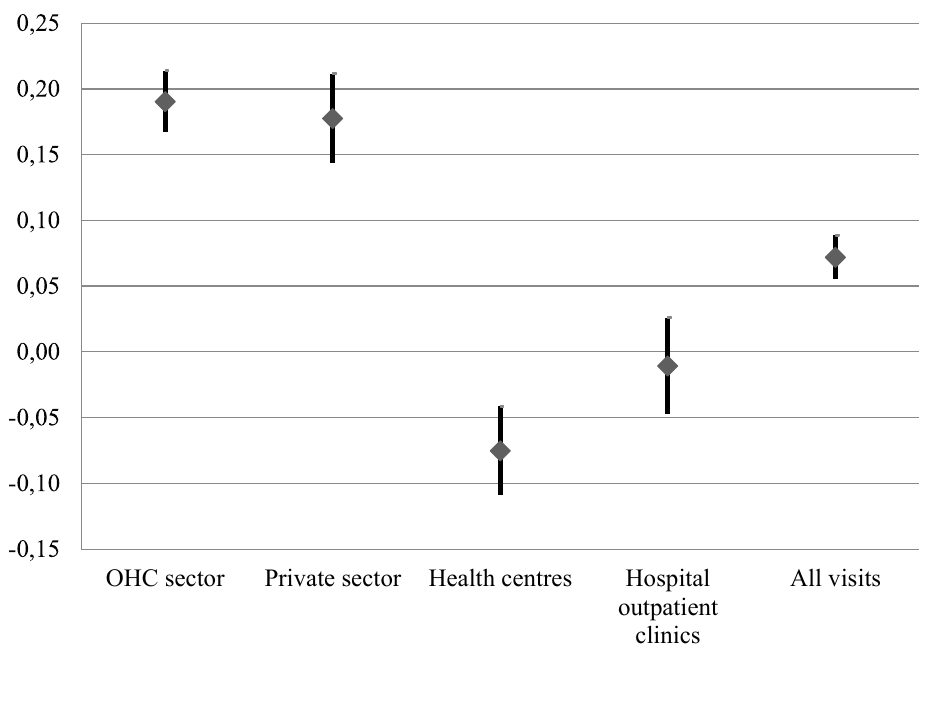
Figure 2. Need adjusted inequity indicies for visits to a doctor